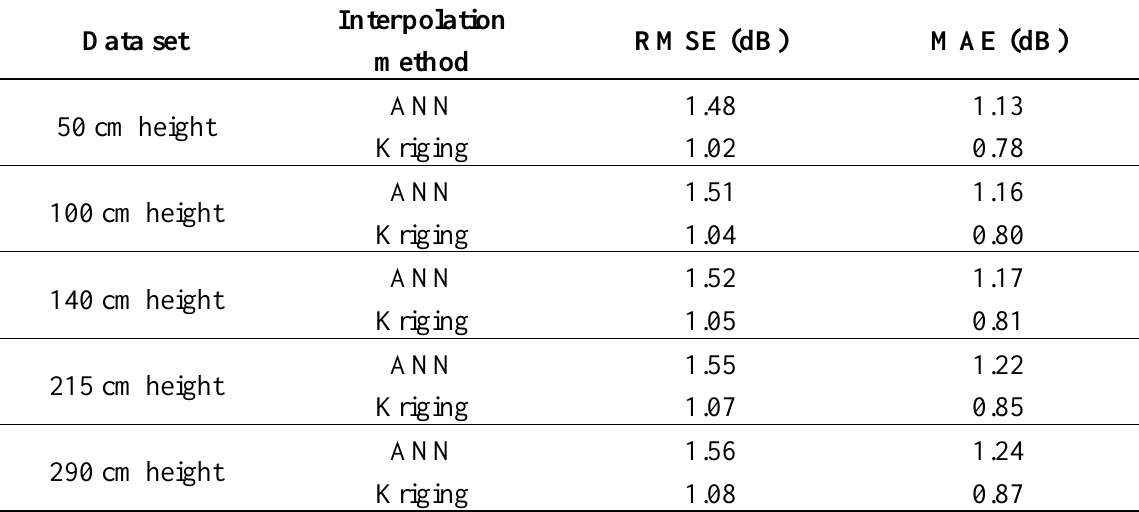
Table 2. Performance of the selected 3-15-1 network and Kriging interpolation of observed points at 50 cm, 100 cm, 140 cm, 215 cm and 290 cm from the floor. MAE, mean after all errors made positive and RMSE, square root of mean squared predicted electromagnetic power minus observed electromagnetic